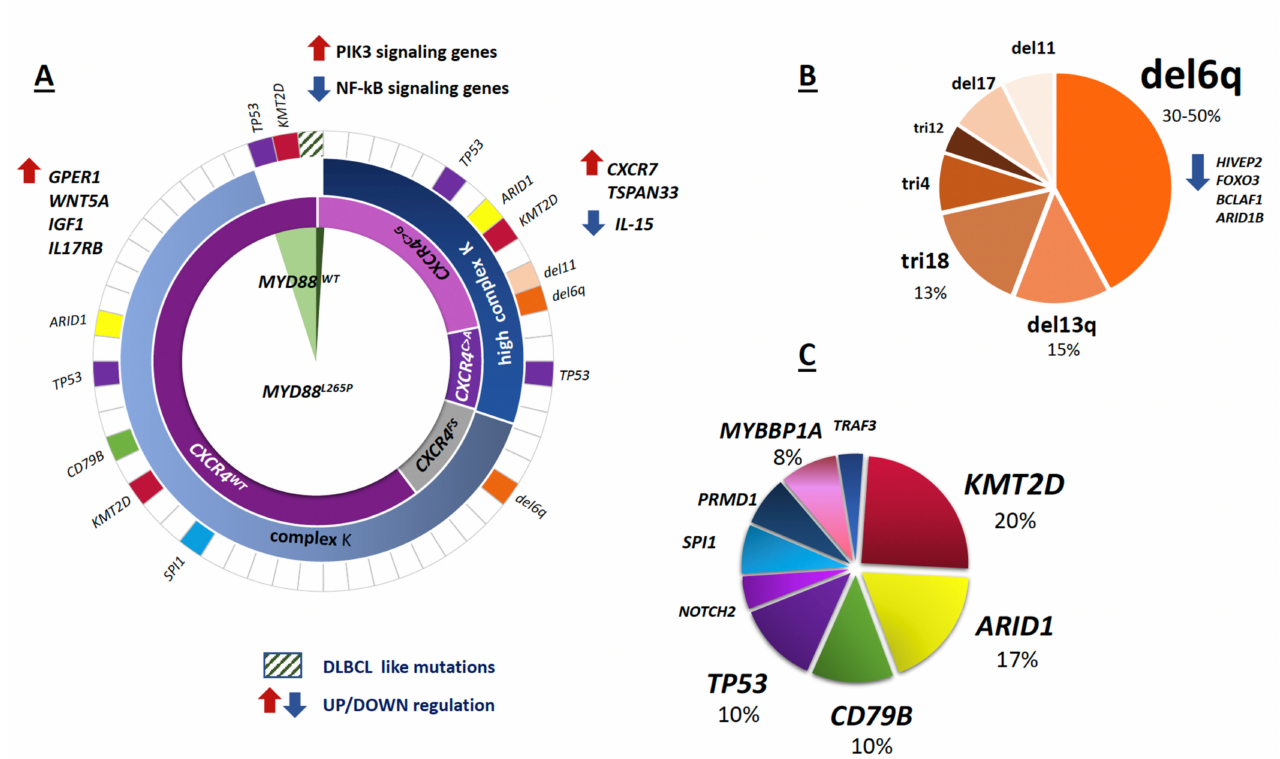
Figure 2. Mutational and cytogenetic landscape of WM. The figure describes the association between genomic abnormalities in WM patients. ( A ) From the center outward, the distribution and overlap of MYD88 L265P mutations, CXCR4 MUT mutations, karyotype (K) (Complex K: <5 clonal aberrations; high complex K: ≥ 5 clonal aberrations), copy number alterations (CNAs) and less frequent mutations (MUTs) are shown, respectively. The color code in the outer ring refers to colors in panels B and C. Relevant up and down-regulated genes (arrows) are reported. DLBCL like mutations: somatic muta- tions overlapping those detected in diffuse large B cell lymphoma (DLBCL), (i.e., TBL1XR1 , PTPN13 , MALT1 , BCL10 , NFKB2 , NFKBIB , NFKBIZ , and UDRL1F ). ( B ) Relative distribution of cytogenetic abnormalities. tri: trisomy, del: deletion. ( C ) Relative distribution of uncommon mutations. The percentage (%) of the most frequent MUTs and CNAs are estimated based on published data, for more details see